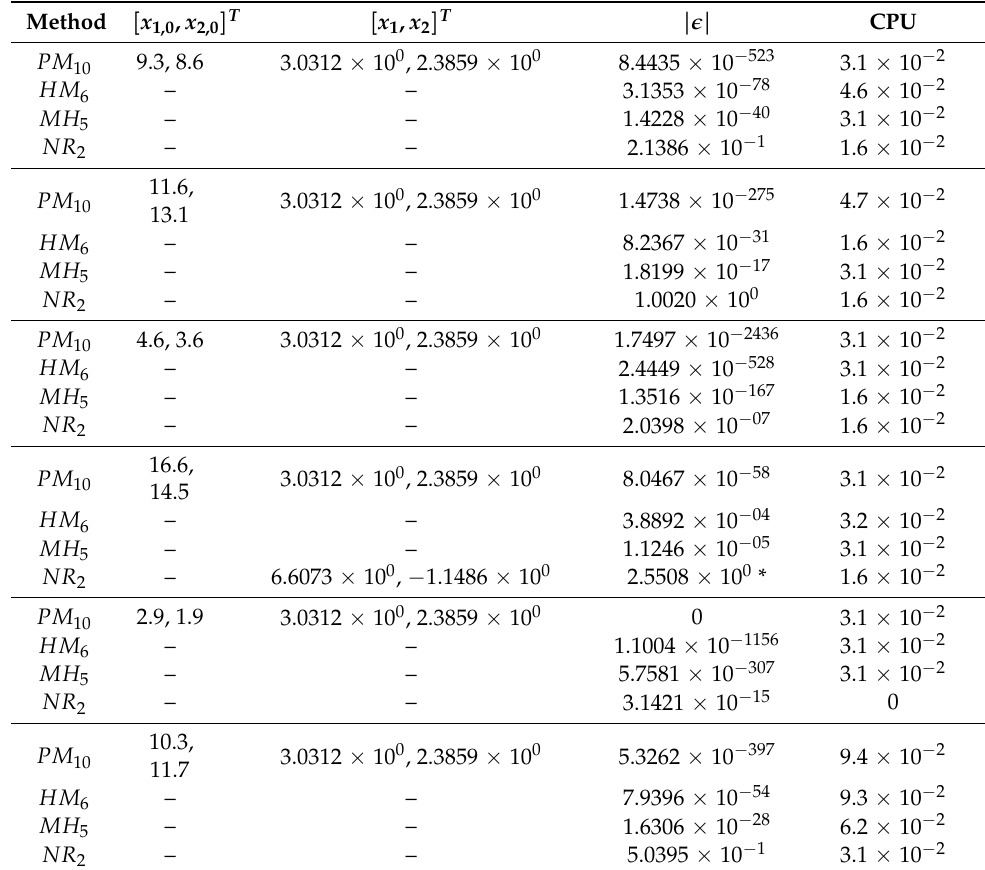
Table 15. Numerical results for problem 10 with ∗ showing the divergence of the method.